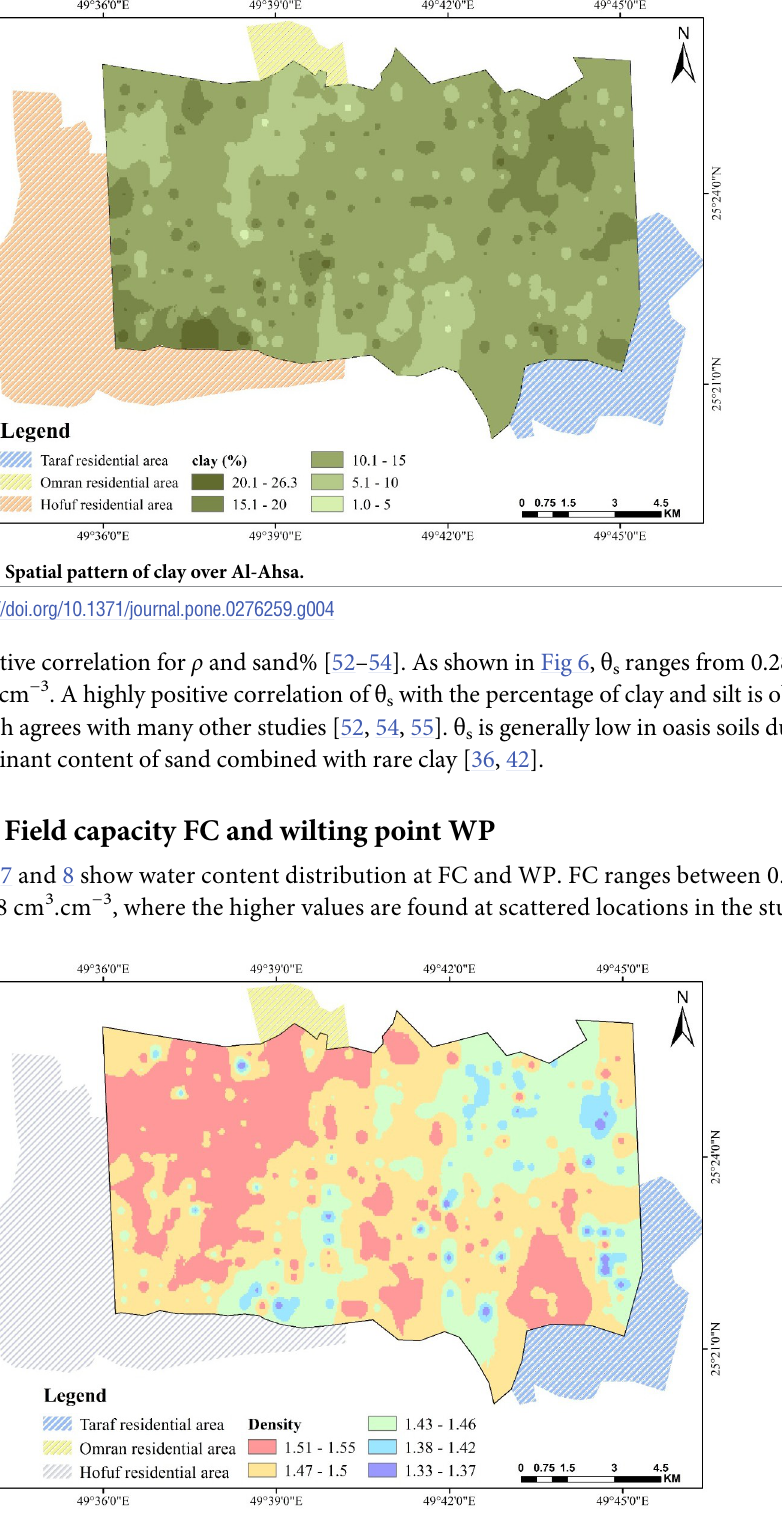
Fig 5. Spatial pattern of bulk density ρ over